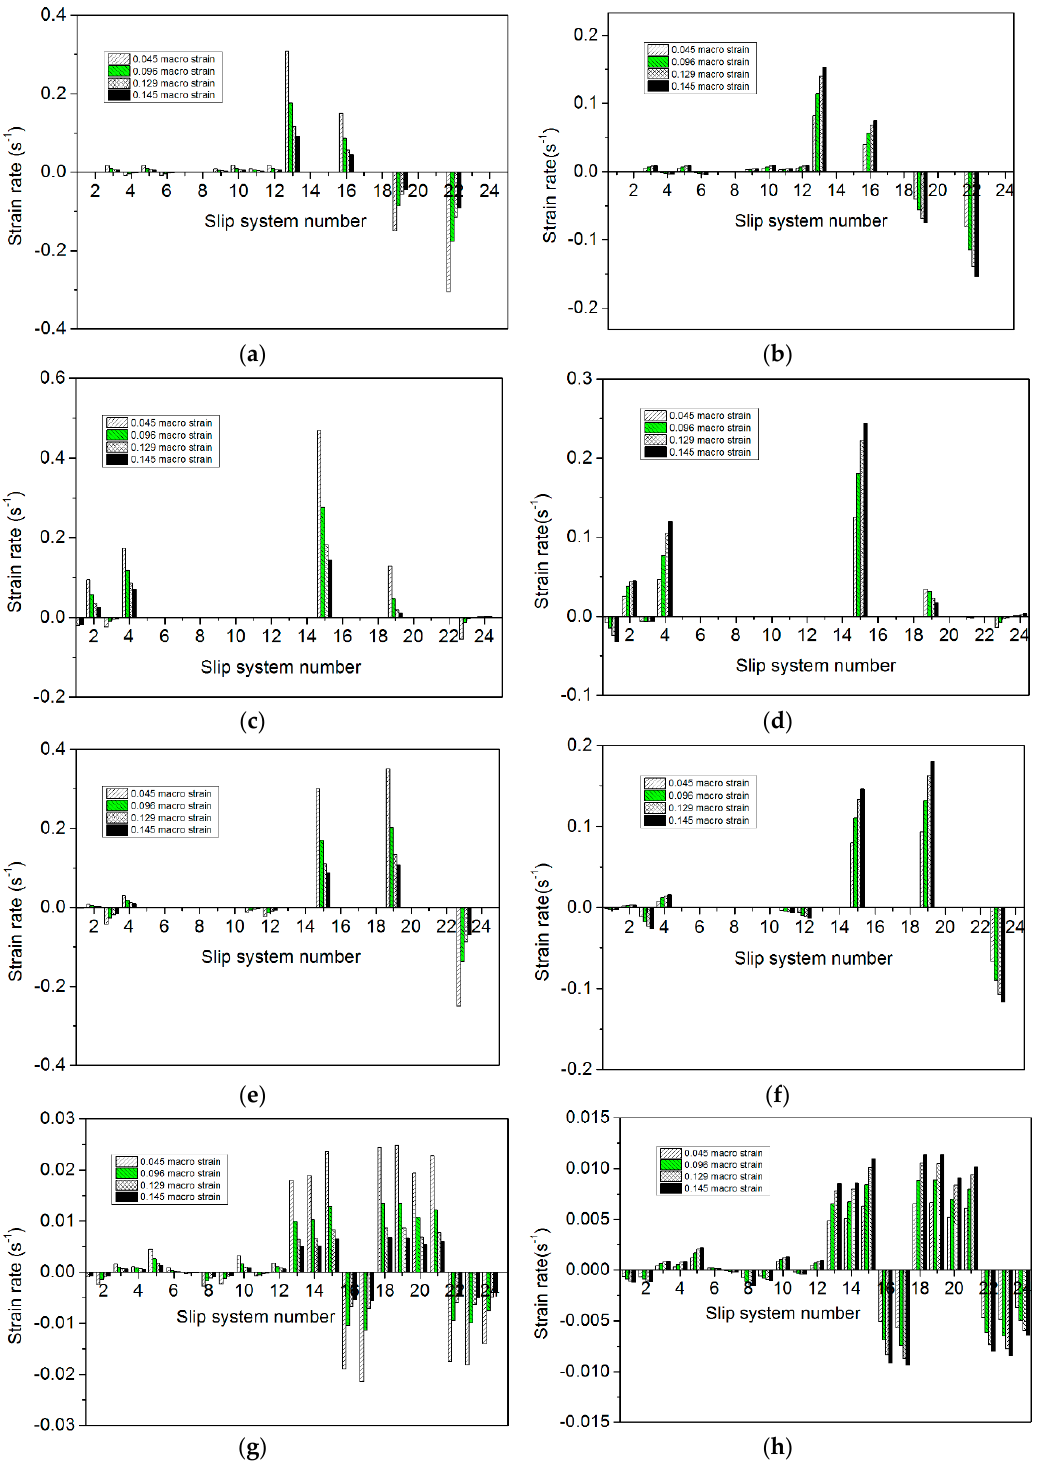
Figure 13. The strain rate of each slip system with different overall strain. ( a ) Ferrite strain rate of Rt ‐ C. ( b ) Martensite strain rate of Rt ‐ C. ( c ) Ferrite strain rate of {111} <112>. ( d ) Martensite strain rate of {111} <112>. ( e ) Ferrite strain rate of ~S. ( f ) Martensite strain rate of ~S. ( g ) The average ferrite strain rate for all grains. ( h ) The average martensite strain rate for all grains.